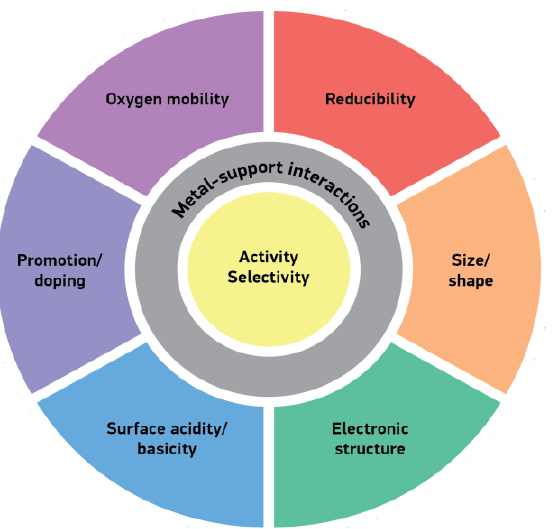
Figure 4. Interrelated and catalytically relevant performance descriptors of ceria-based materials.